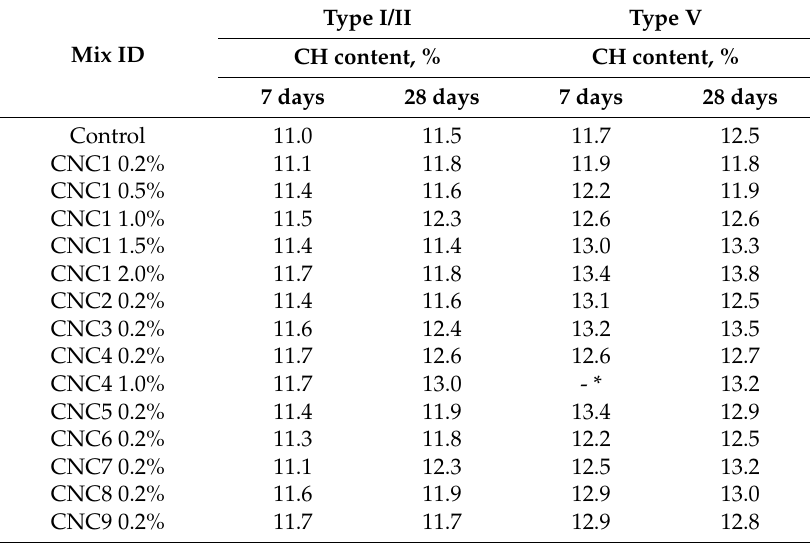
Table 4. Summary of TGA results. CH, calcium hydroxide.